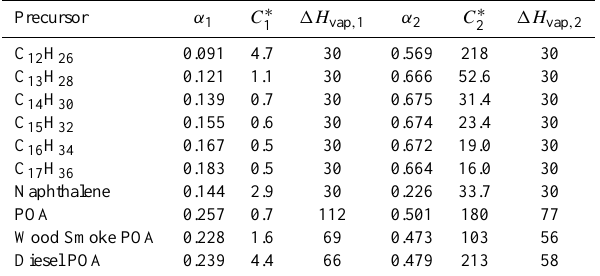
Table 2. 2p-VBS parameters based on VBS parameters for alkanes (Presto et al., 2010), naphthalene (Pye et al., 2010), undifferentiated POA (Shrivastava et al., 2008), wood smoke POA and diesel POA (Grieshop et al., 2009) under high-NO x conditions for T = 298K and ρ = 1.0gcm − 3